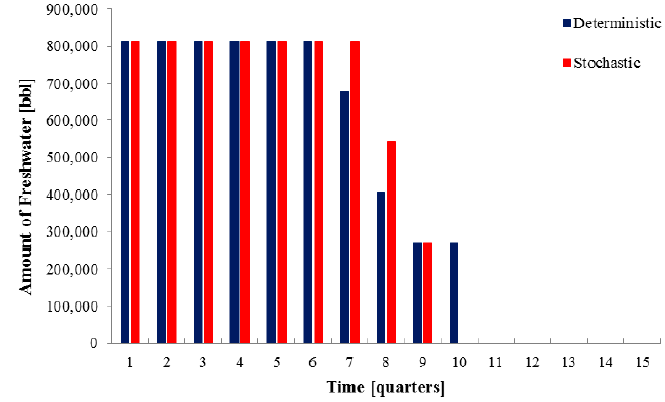
Figure 7. Amount of water required in shale sites for deterministic and stochastic cases.